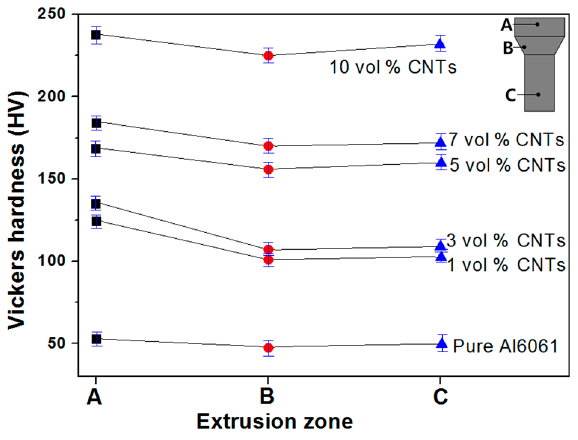
Figure 9. Vickers hardness at three extrusion zones (formed by 520 °C and R = 4).